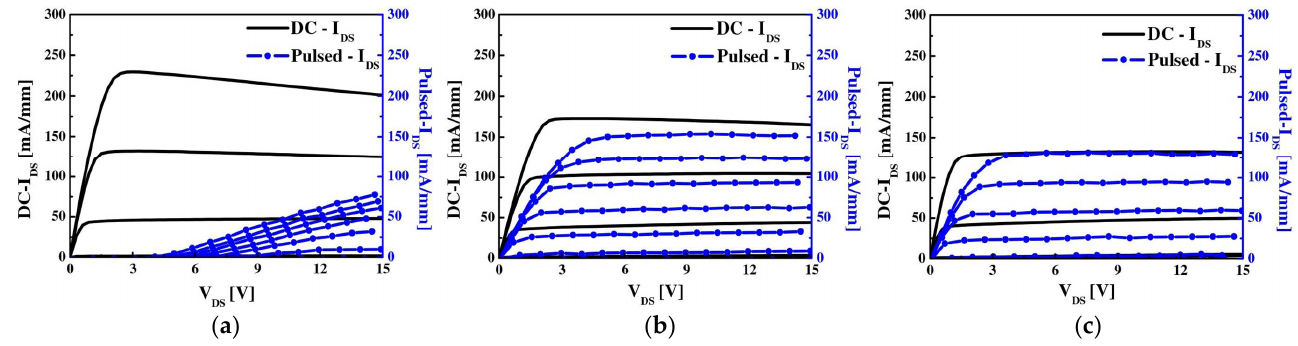
Figure 4. DC and pulsed I DS –V DS characteristics for the GaN device. ( a ) Without pretreatment; ( b ) with NH 4 OH/N 2 pretreatment; ( c ) with NH 4 OH/NH 3 pretreatment. DC and pulsed I DS –V DS were measured at V DS = 0 to 15 V and V GS = −3 to 1 V. The pulse width and period were 500 ns and 1 ms. Adapted with permission from Ref. [26]. Copyright 2010, The Japan Society of Applied Physics.